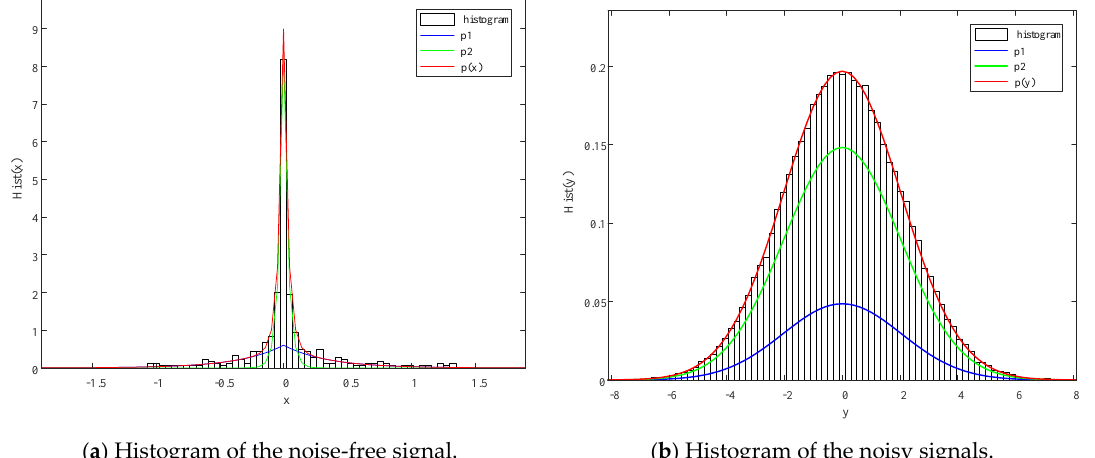
Figure 3. Histogram of related signals.